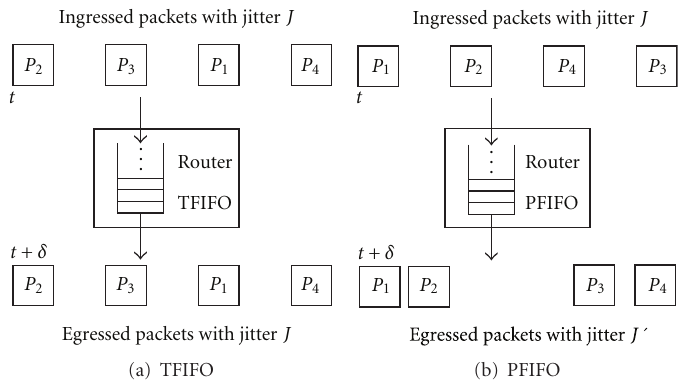
Figure 4: Comparison of router queuing disciplines.